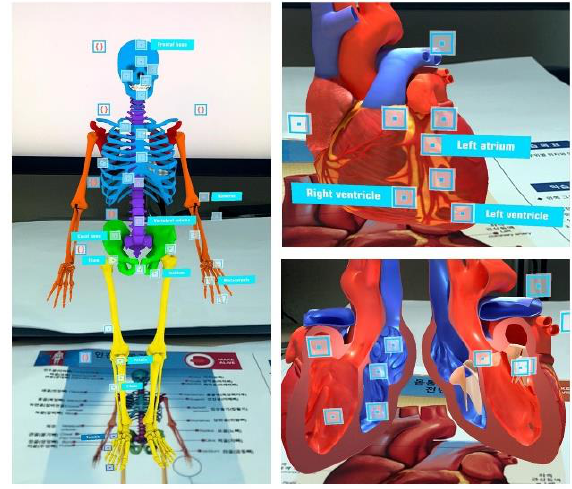
Figure 1. Screenshot from the Augmented Reality Application.